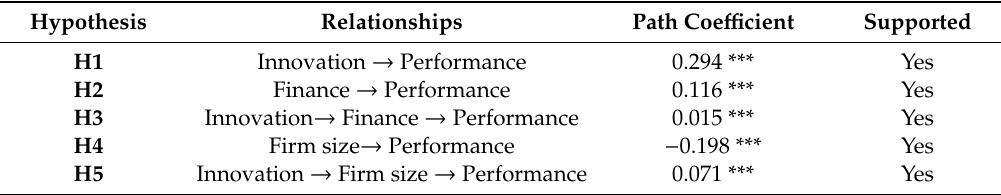
Table 8. Hypothesis testing